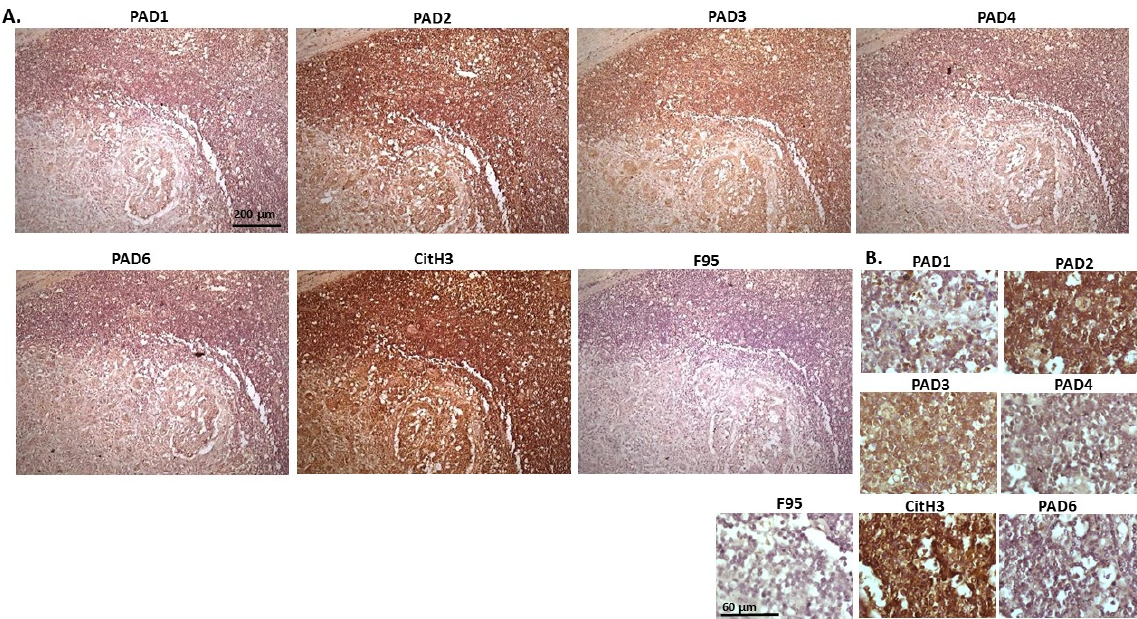
Figure 8. Cow, metastatic carcinoma, lungs and lymph nodes. Organ samples showed tumour in lungs and lymph nodes; origin of the primary tumour unknown. ( A ) Overview images for PAD1, 2, 3, 4, 6, CitH3 and F95 stainings of serial tissue sections; scale bar represents 200 μ m for all images; 10× objective. ( B ) Higher magnification shown for each staining from the images in ( A ); scale bar represents 60 μ m for all images; 40× objective.